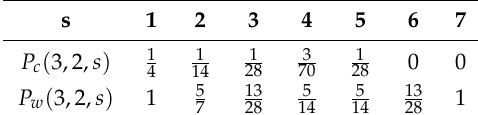
Table 2. Values of P c ( 3,2, s ) and P w ( 3,2, s ) for s ≥ 1.